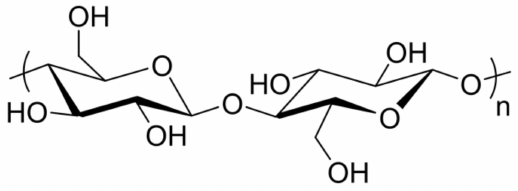
Figure 3. Cellulose chemical